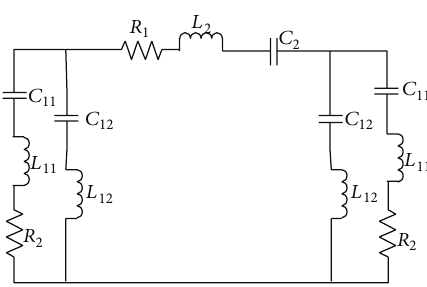
Figure 4: Microstrip coupled line gap equivalent circuit